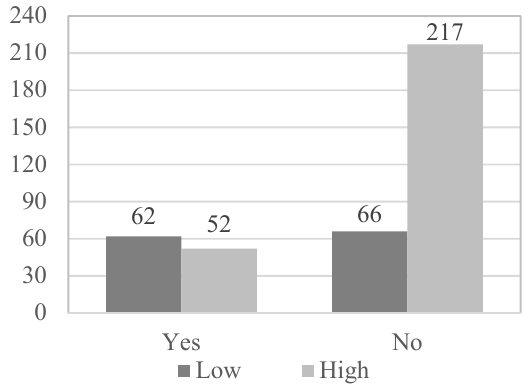
Figure 1. Physical illness_Health satisfaction.